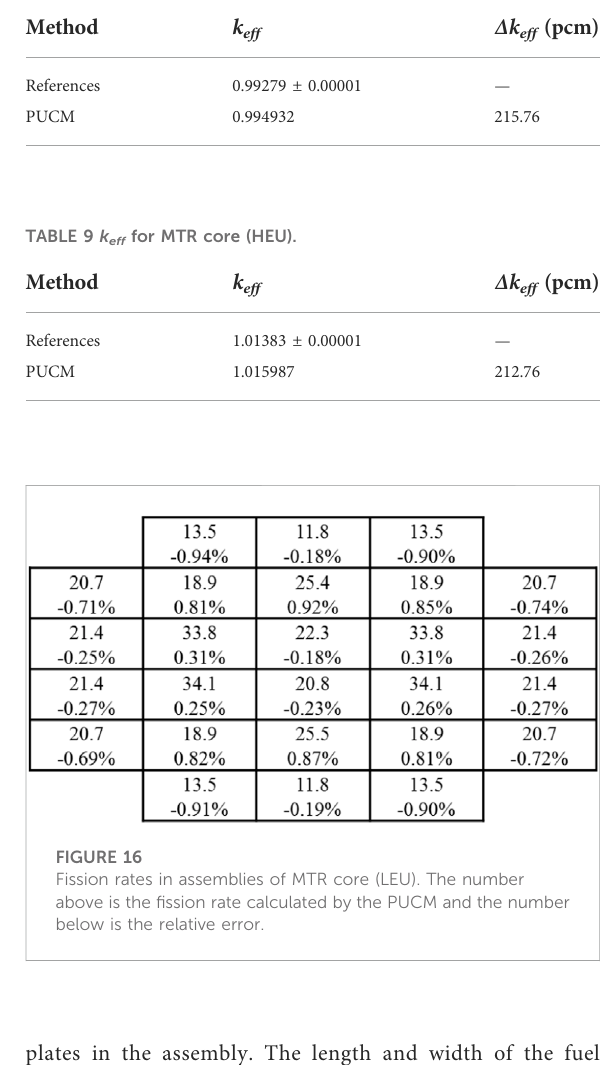
TABLE 8 k eff for MTR core (LEU).